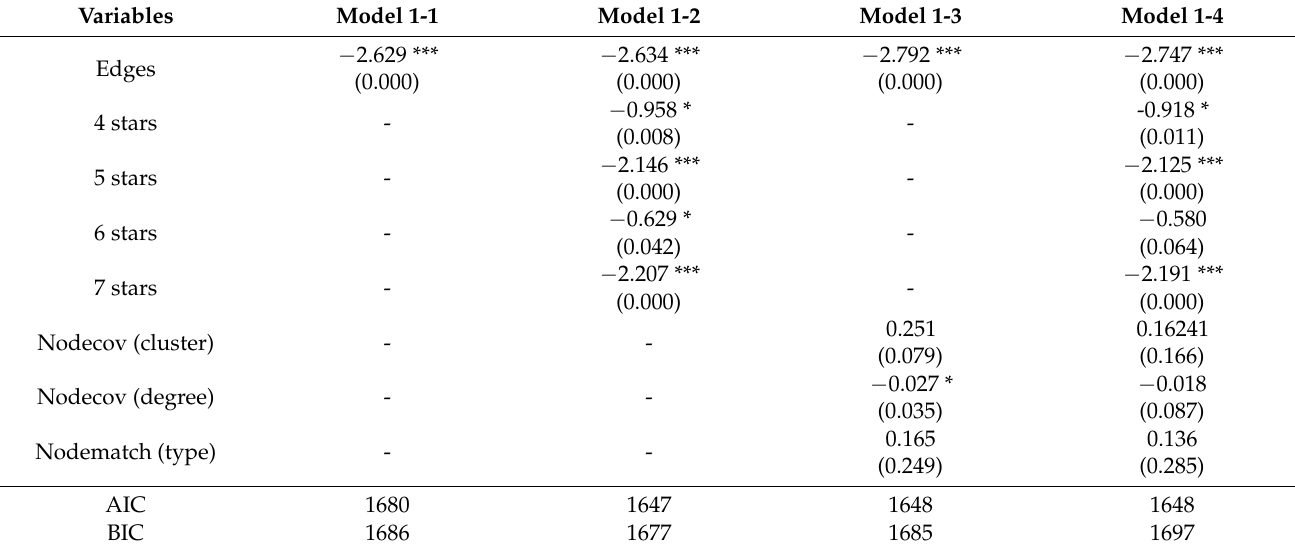
Table 6. Results of the institutional network (Net1).